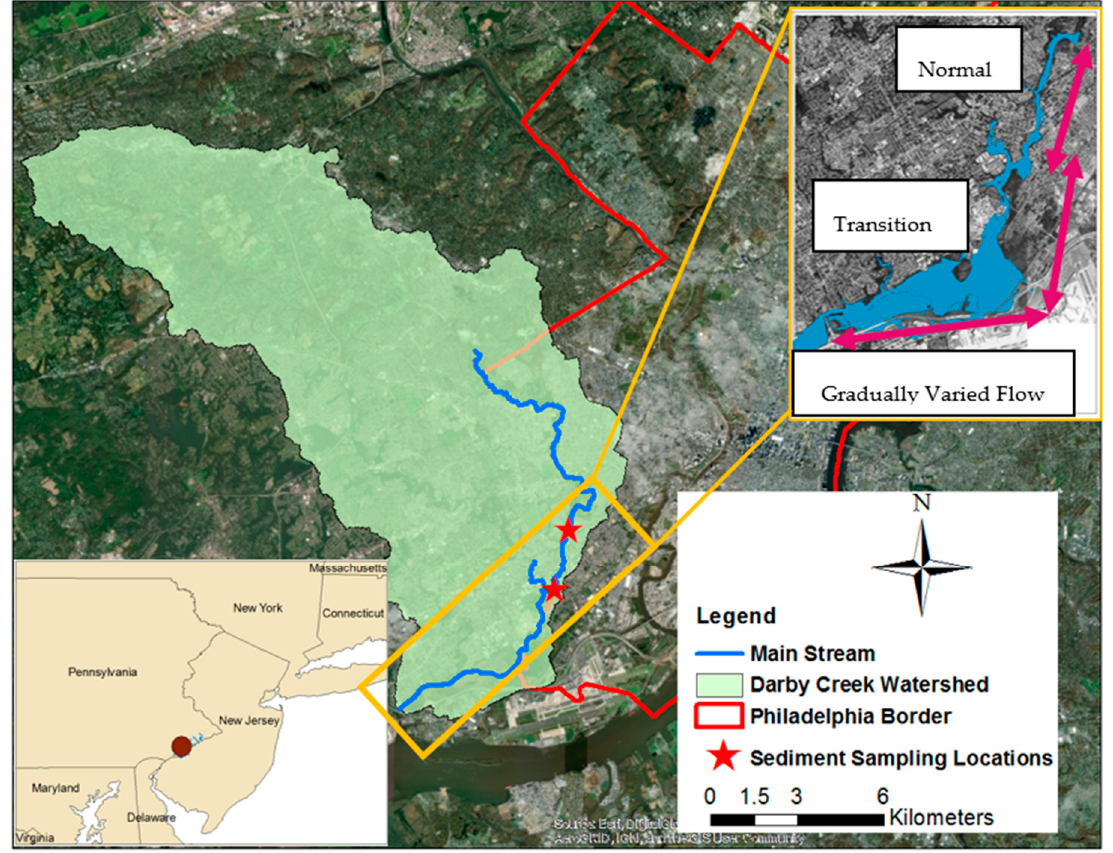
Figure 1. The study area is lower Darby Creek located in southeast Pennsylvania. The creek flows through a fully urbanized watershed and delivers its discharge into the Delaware River. (Image from World Imagery, ArcGIS online).